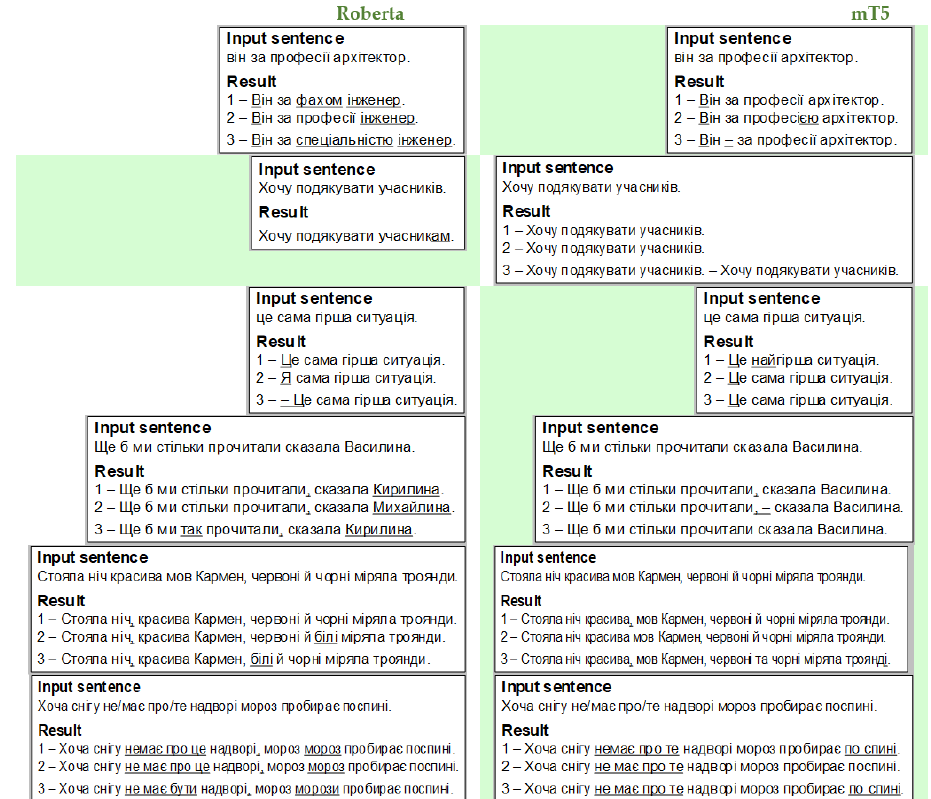
Figure 19. Variants of correction by different neural network models.